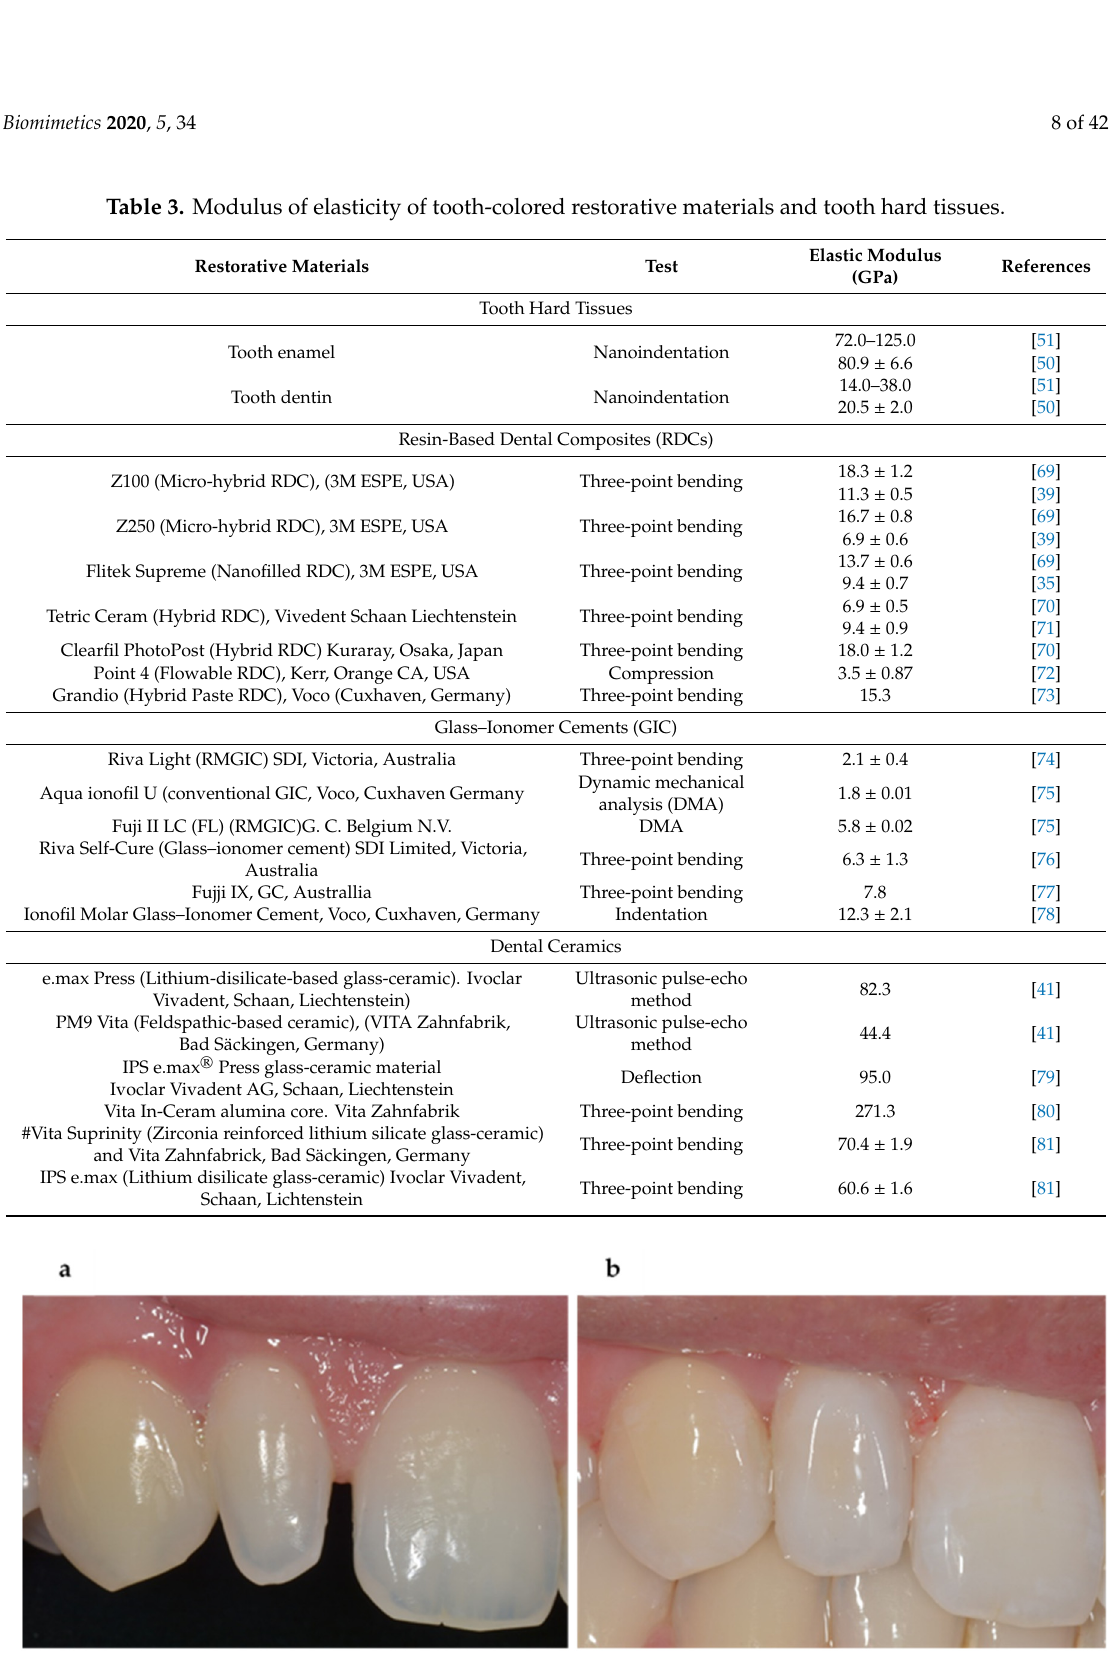
Figure 2. Restoration of peg-shaped lateral incisor using the direct restorative composites; ( a ), pre-operative image of lateral incisor showing peg shape ( b ), post-operative image showing the restoration of the defect matching morphology and color similar to the adjacent natural teeth.